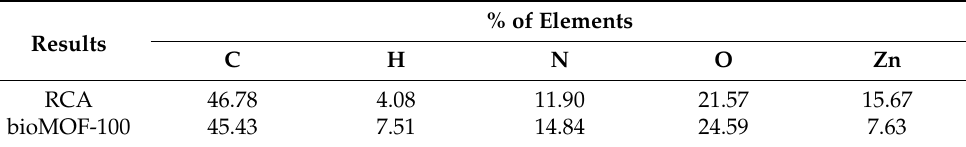
Table 2. Elemental analysis for RCA and comparison with